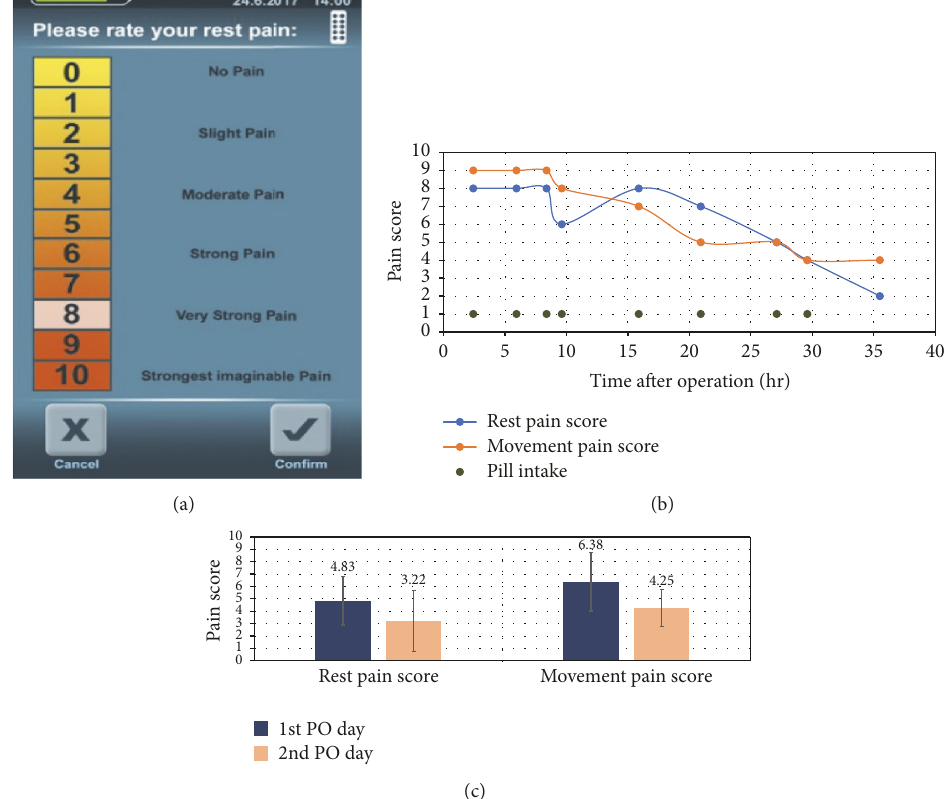
Figure 6: Pain scores recorded by PCoA Acute system, obtained by patients in the test group. (a) PCoA Acute survey’s touch screen, demonstrating rest pain scoring (similar screen is that used to score movement pain). (b) Example of a selected patient with representative data of rest and movement pain scores obtained at each pill intake event. (c) Pain scores data analysis of patients in the test group ( 𝑁 = 18 , who scored their pain at pill intake), demonstrating statistically significant pain reduction from the 1st postoperative (PO) day to the 2nd.